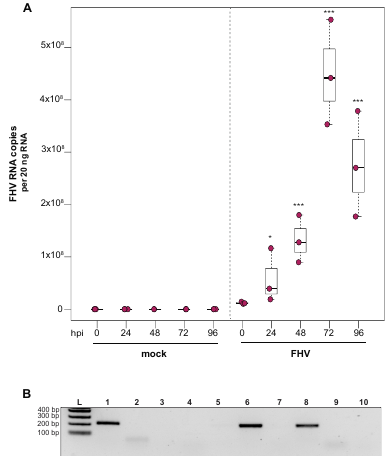
Figure 4. Flock House virus (FHV) replicates in primary honey bee hemocytes. FHV abundance in mock- or FHV-infected (1 × 10 6 FHV RNA copies) hemocytes was assessed over time (i.e., 0 hpi, 24 hpi, 48 hpi, 72 hpi, and 96 hpi). ( A ) FHV abundance was higher at 24 hpi (3.7 × , p = 0.026), 48 hpi (10.7 × , p < 0.001), and 72 hpi (37 × , p < 0.001), relative to 0 hpi. FHV abundance reduced from 72 hpi to 96 hpi ( p = 0.034) but was significantly higher ( p < 0.001) relative to 0 hpi. Raw data are included